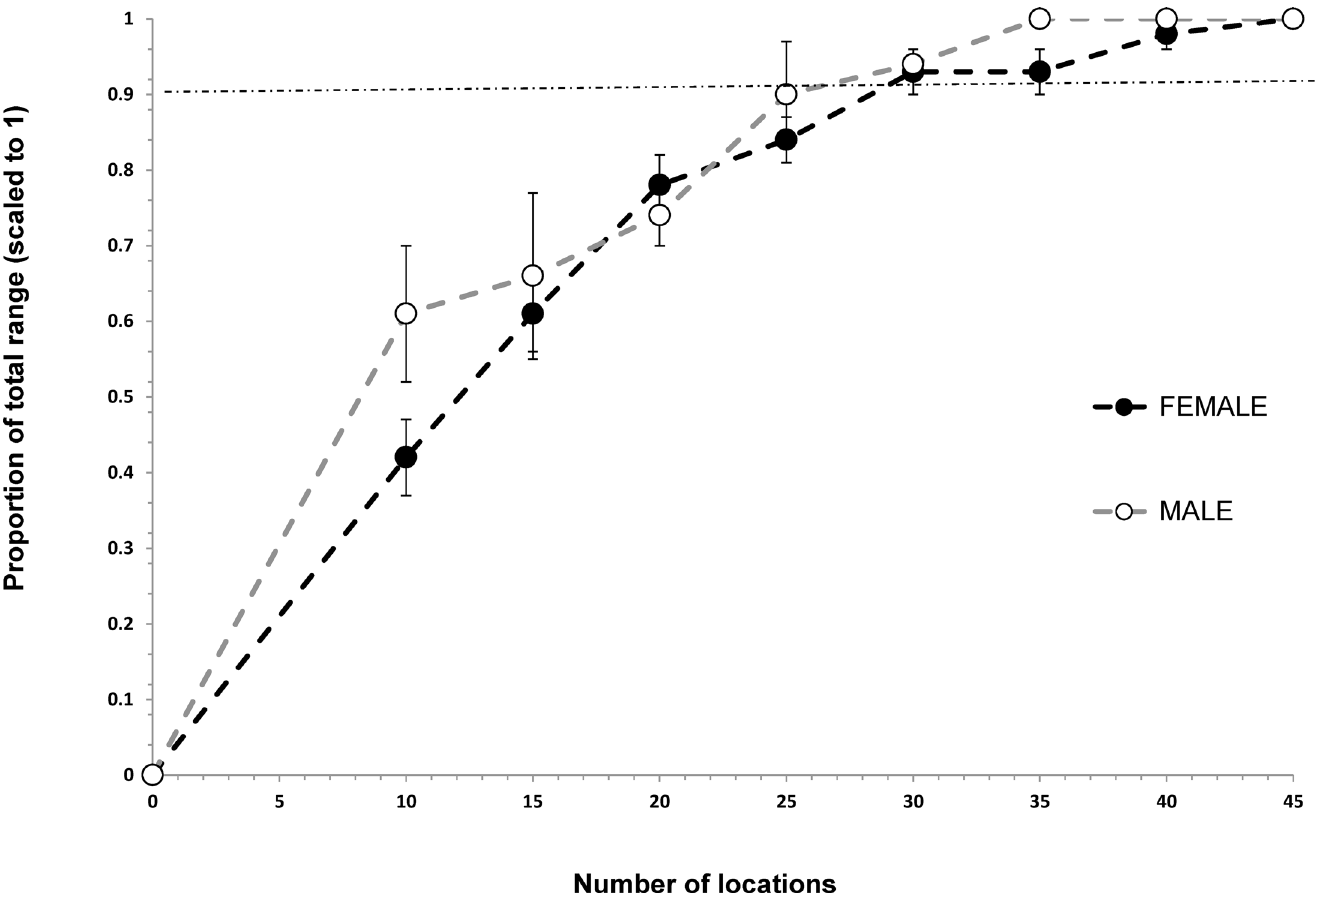
Fig 4. Incremental 95% MCP accumulation curve showing the number of locations required to more accurately estimate the dry season (Apr-Sep) home ranges for black rhino in Hluhluwe-iMfolozi Park (HiP), South Africa. Note that the horizontal dashed line represents the within 10% level of the total home range recommended for increased